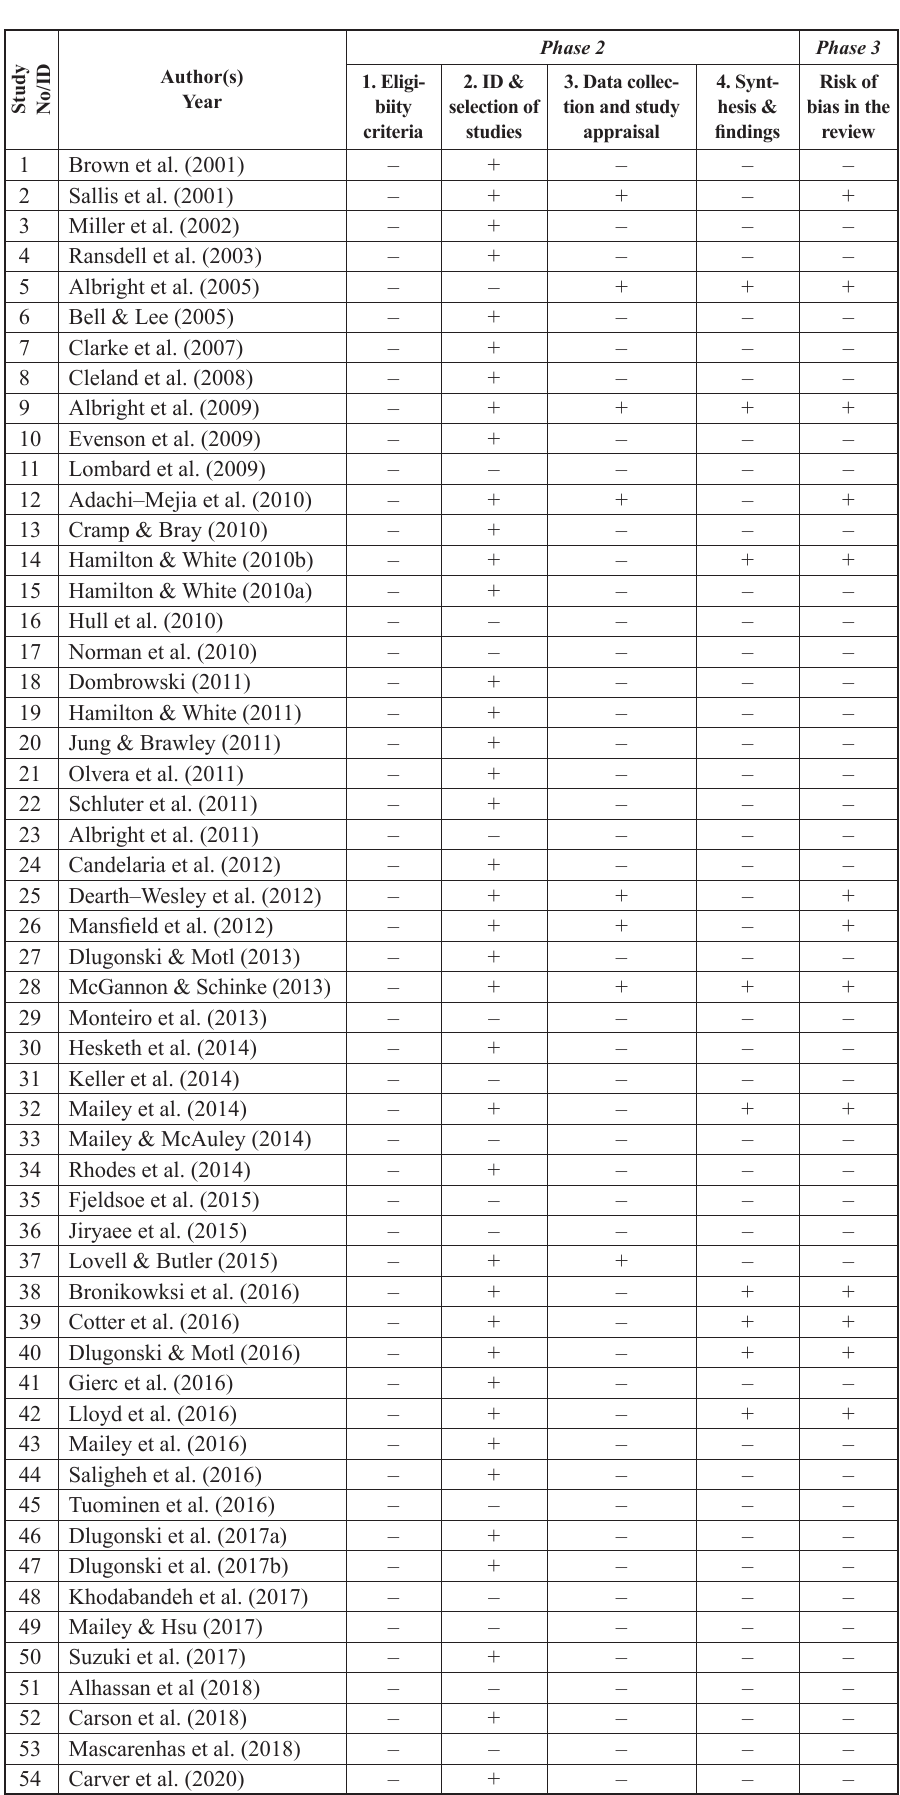
Table 2. ROBIS risk assess- ment of bias in the systematic review